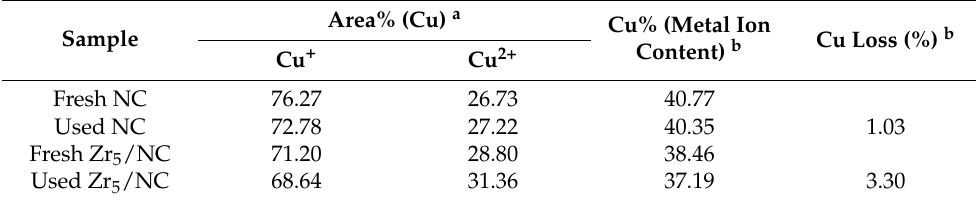
Figure 6. XPS spectra of catalysts, ( a ) the Cu2p spectra and ( b ) XPS survery spectra. Table 2. Relative contents and binding energies of Cu + and Cu 2+ in the fresh and used catalysts as determined by XPS and ICP-OES ( a denotes the determination using XPS, and b denotes the determination using